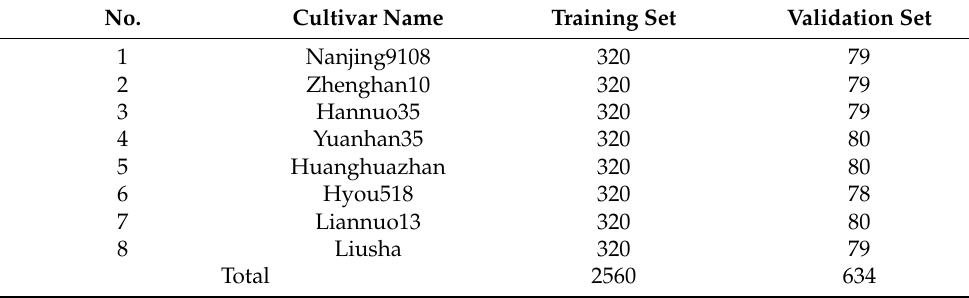
Table 1. Rice seed dataset.